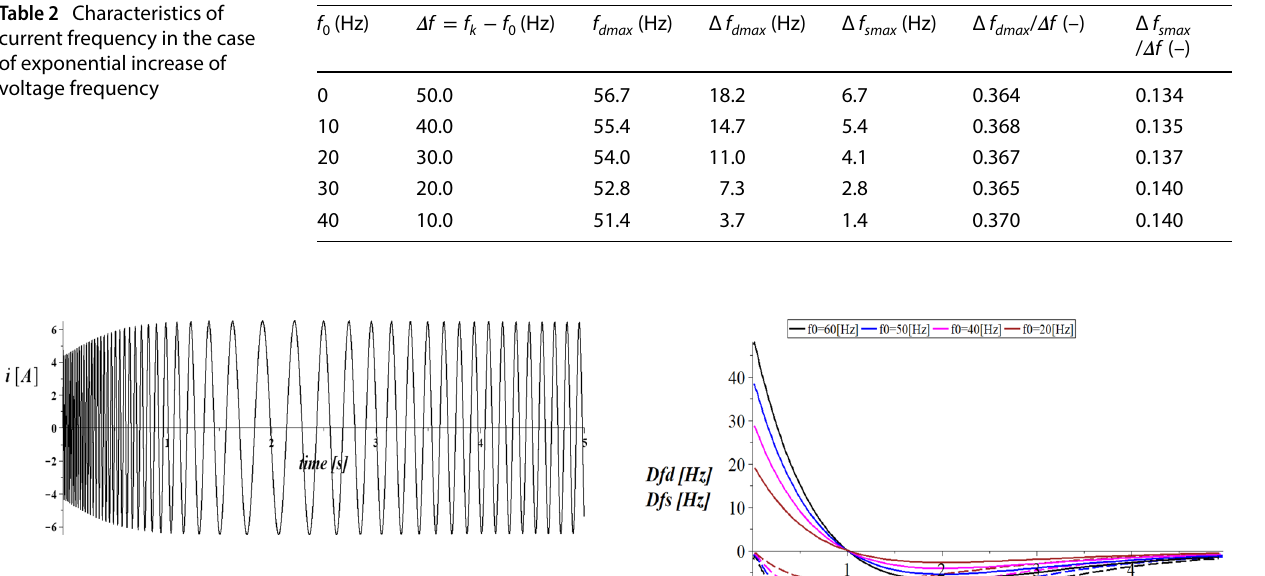
Fig. 13 Electric current in R,L circuit for exponential frequency decrease from f 0 = 60 (Hz) to f k = 10 (Hz) ; T = 0.075 (s)